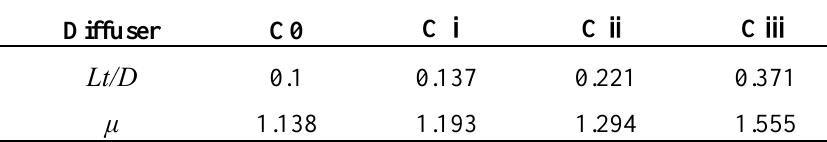
Table 2. Parameters of C-type wind-lens. For C0–Ciii diffuser, see Figure